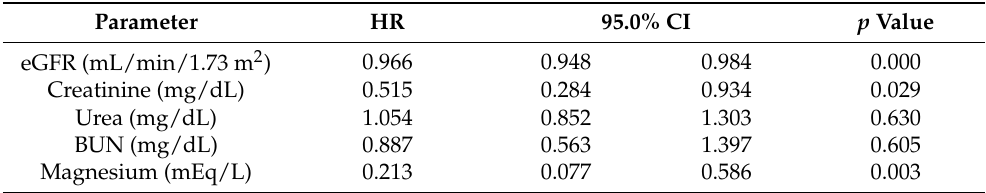
Table 3. Cox regression proportional hazards model with cumulative risk considering renal function and electrolyte status in obese patients with COVID-19. The analysis was adjusted for age and biological